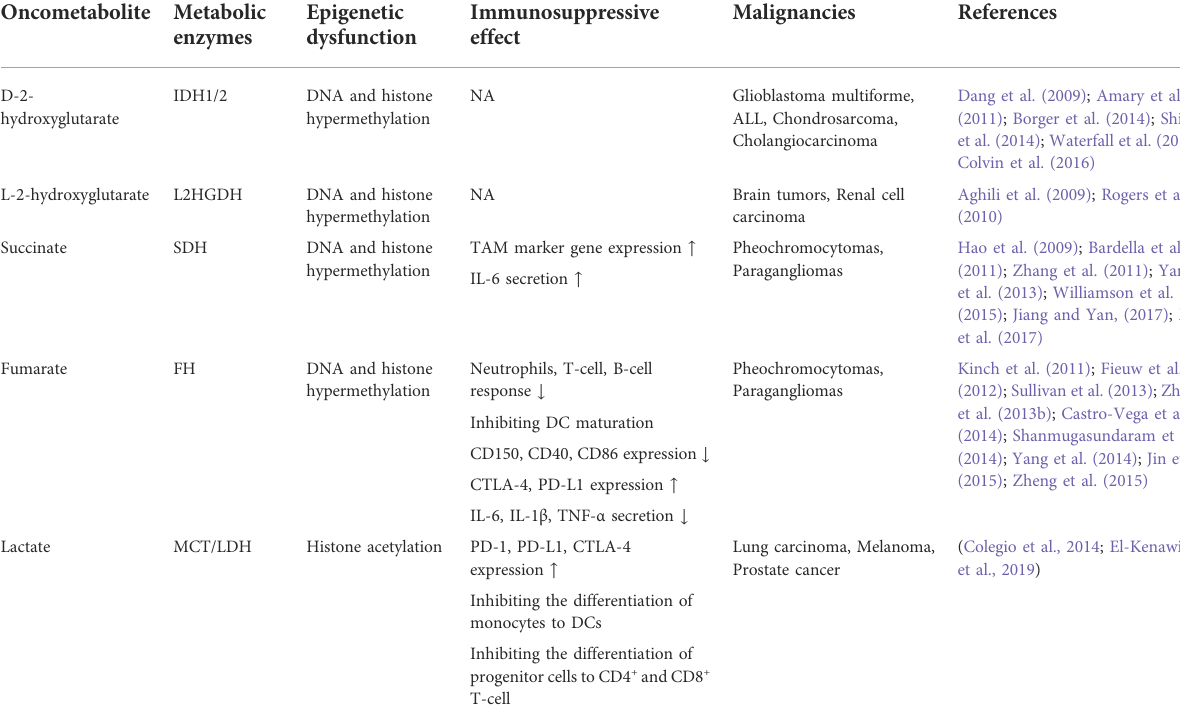
TABLE 3 The effect of oncometabolites on epigenetic dysfunction and